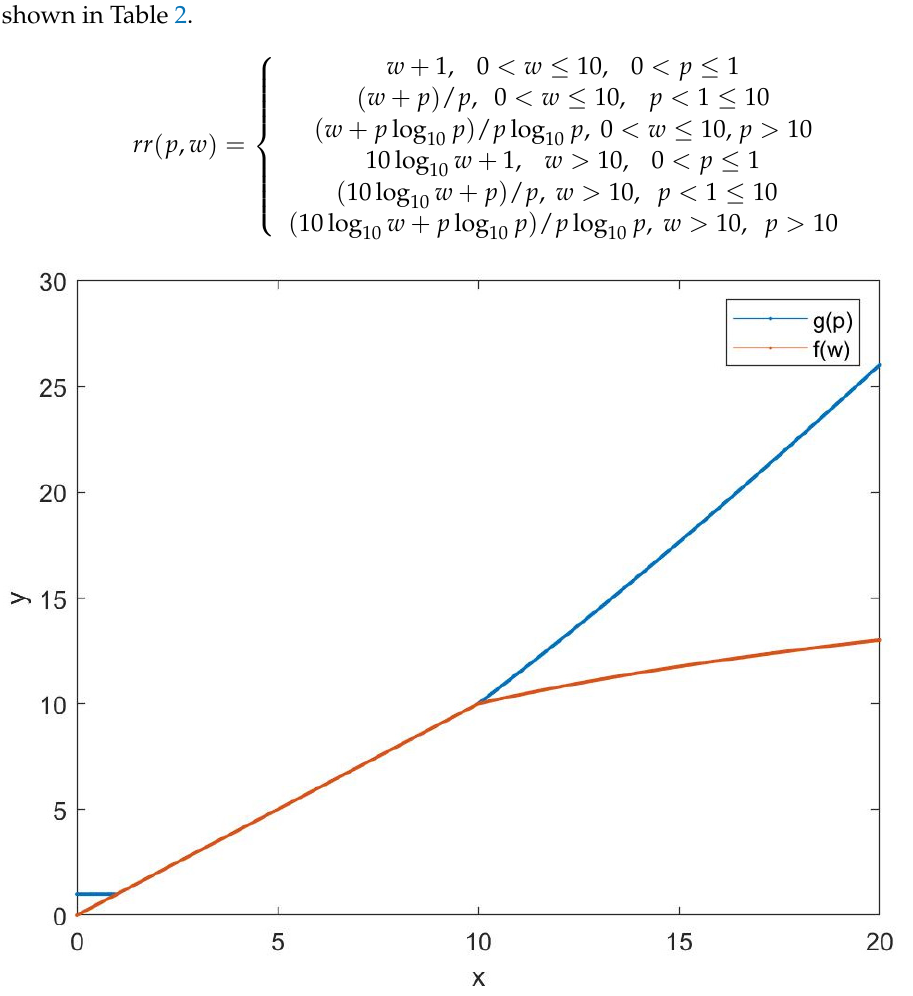
Table 2. The statues of requests. “Not applicable” means that someone has not arrived or left. “Yes” means a person has entered the canteen with permission already. “Waiting” indicates that a stu- dent’s request cannot be immediately satisfied. Note that not every moment is listed.